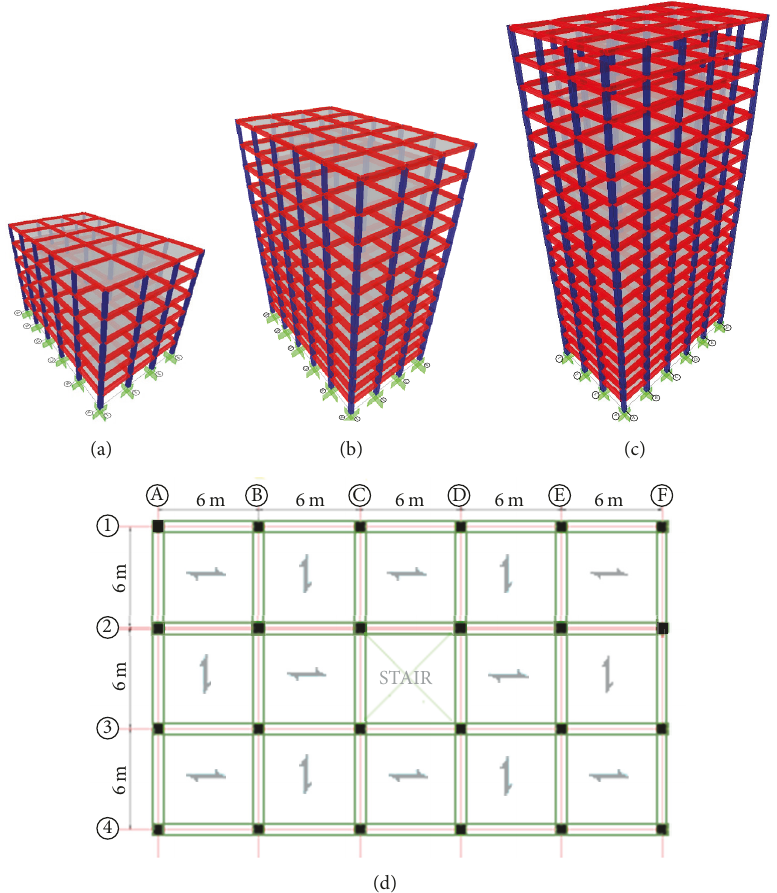
Figure 4: Structural elevation and plan: (a) 6-story building, (b) 12-story building, (c) 18-story building, and (d) typical plan.